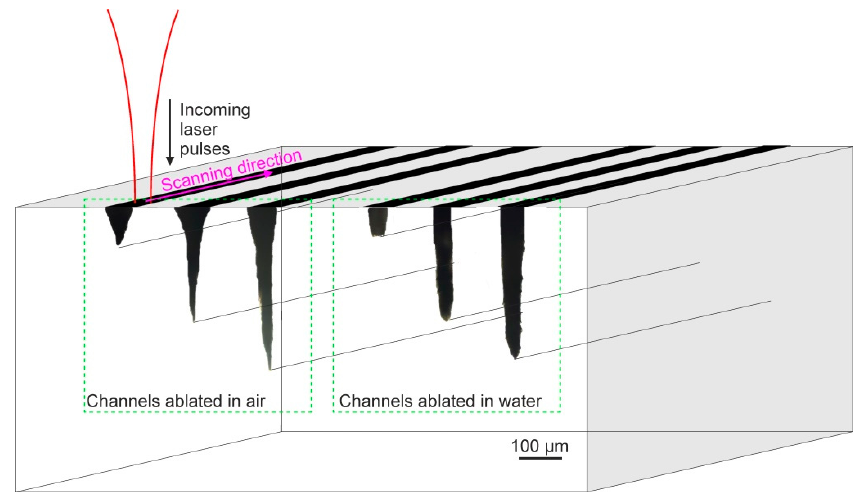
Figure 7. Craters produced when ablating in air and when the samples are covered with a water layer. A different number of scans is required to reach a specific depth, one can estimate this number for